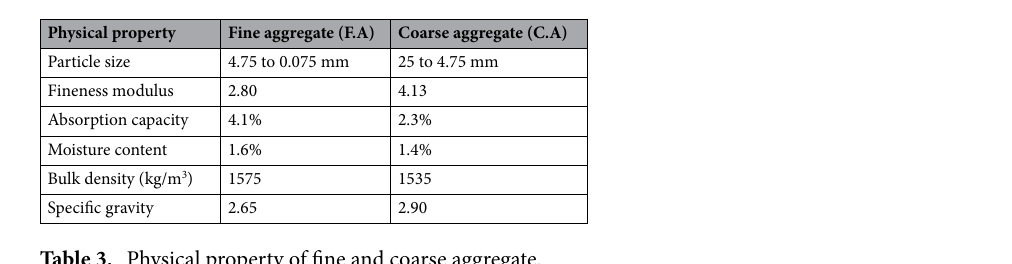
Table 3. Physical property of fine and coarse